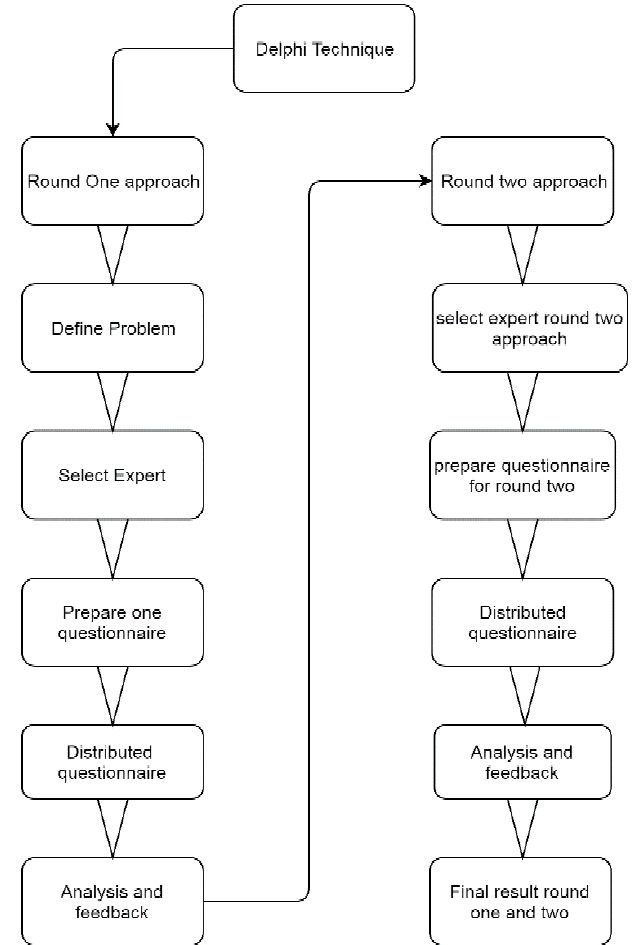
Figure 3. Framework of the Delphi approach used in the current study.